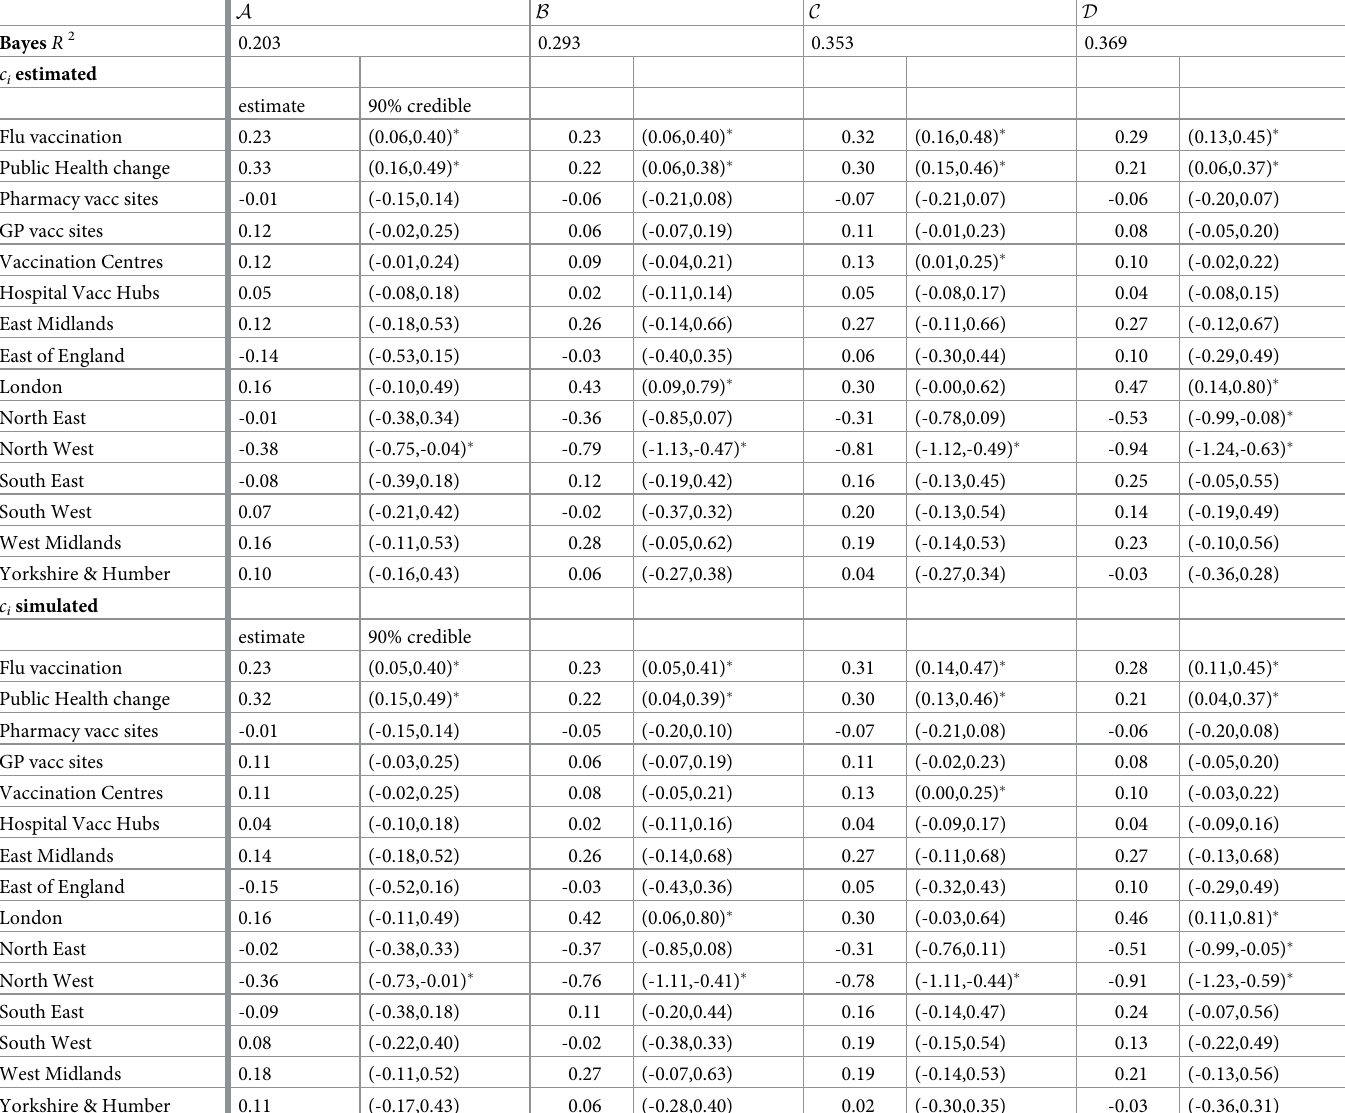
Table 2. Parameter estimates from 2nd stage modelling of random effects for Third